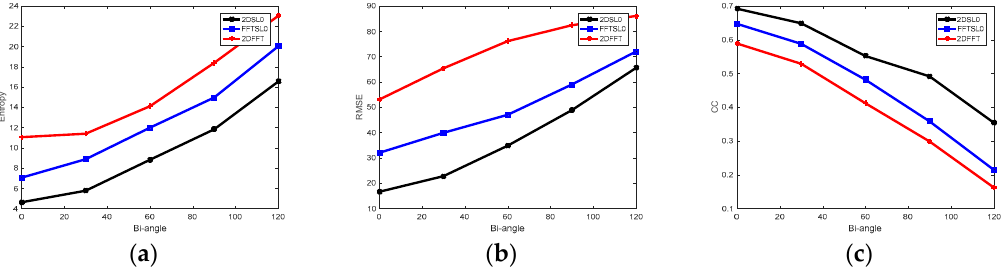
Figure 6. Curves of imaging performance under different bi-angles. ( a ) Entropy versus bi-angle; ( b ) RMSE (root mean square error) versus bi-angle; ( c ) CC (correlation coefficient) versus bi-angle.